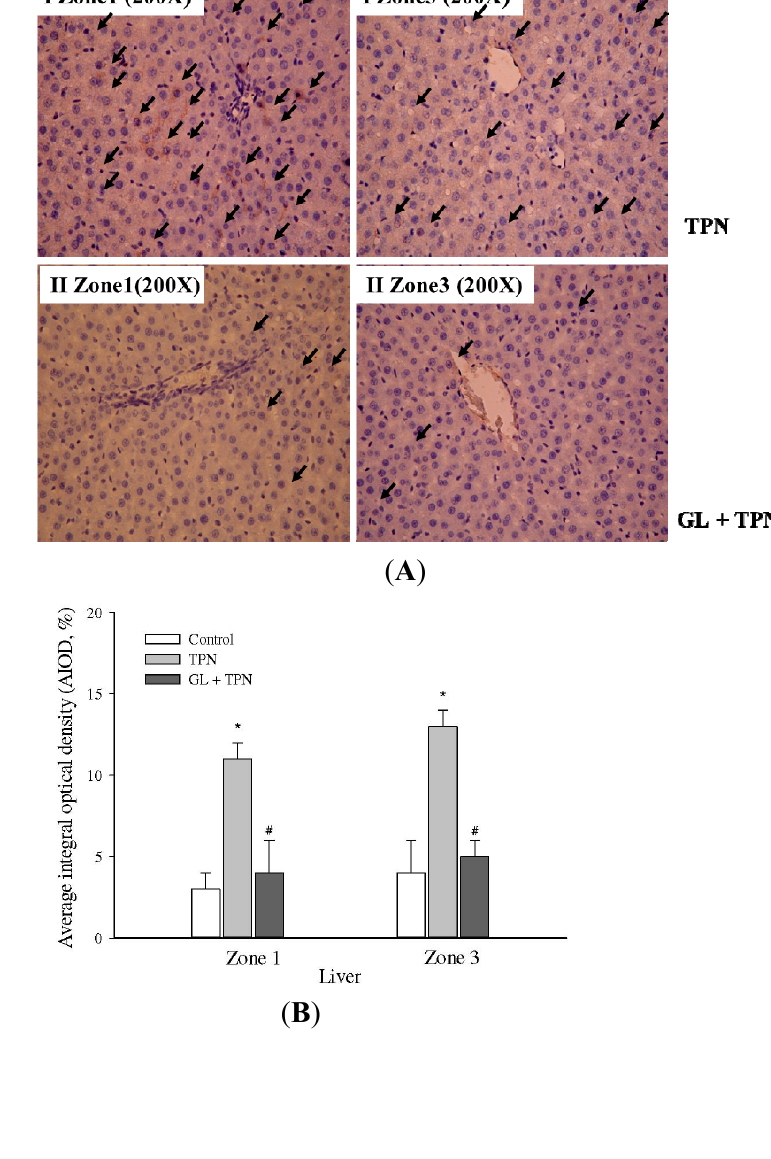
Figure 4. Immunohistochemical analysis of cleaved caspase-3 staining in rat livers